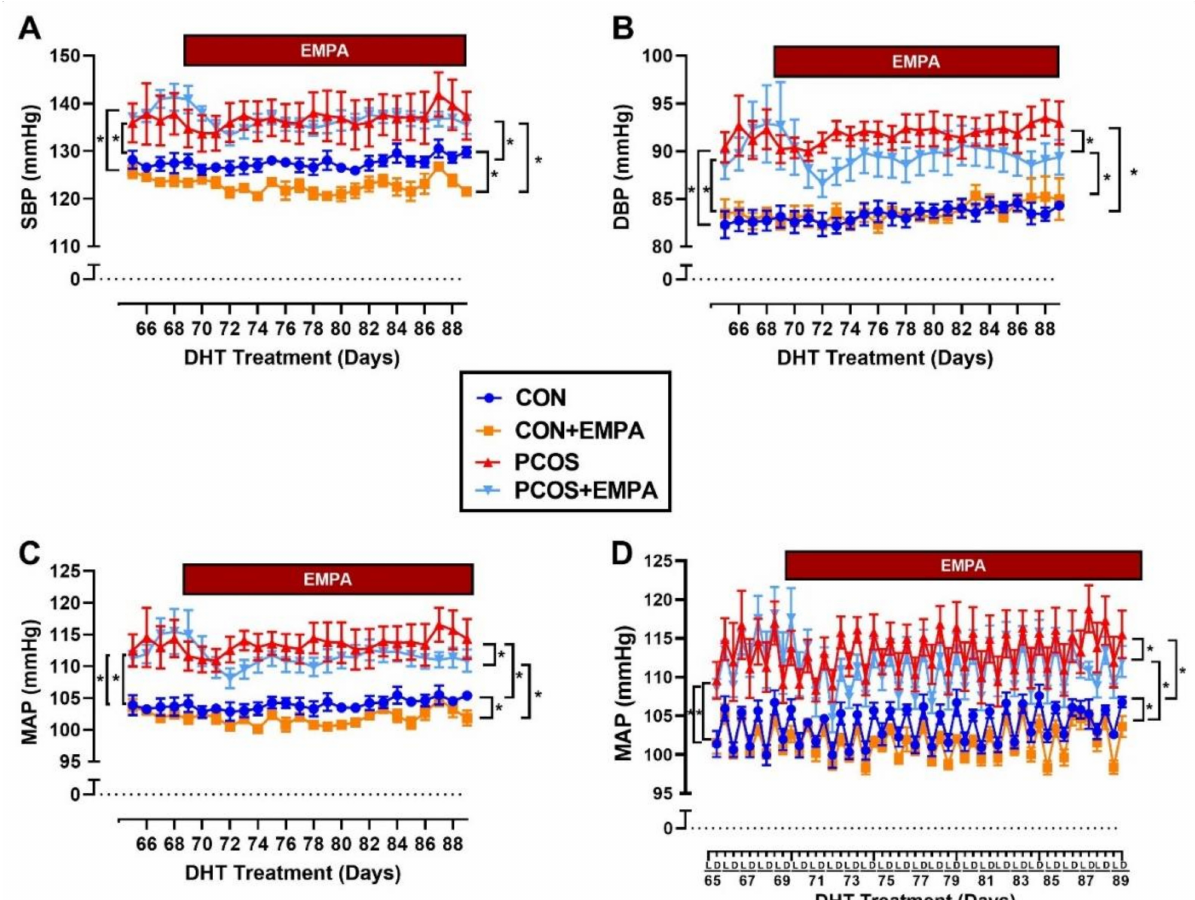
Figure 5. Effect of EMPA on blood pressure and heart rate in PCOS. ( A – C ) Effect of EMPA on ( A ) systolic BP (SBP), ( B ) diastolic BP (DBP), and ( C ) mean arterial pressure (MAP) during last 3 weeks of DHT, with 4 days of baseline measurements. ( D ) Effect of EMPA on the light (L) and dark ( D ) phases of the circadian rhythm of MAP during the last 3 weeks of DHT, with 4 days of baseline. Data are expressed as mean ± SEM. Data was analyzed by two-way repeated measures ANOVA followed by Tukey post-hoc tests, with separate analyses for both baseline and for during EMPA treatment. No significant interactions were observed by two-way repeated measures ANOVA. * p < 0.05. n = 5–7 per